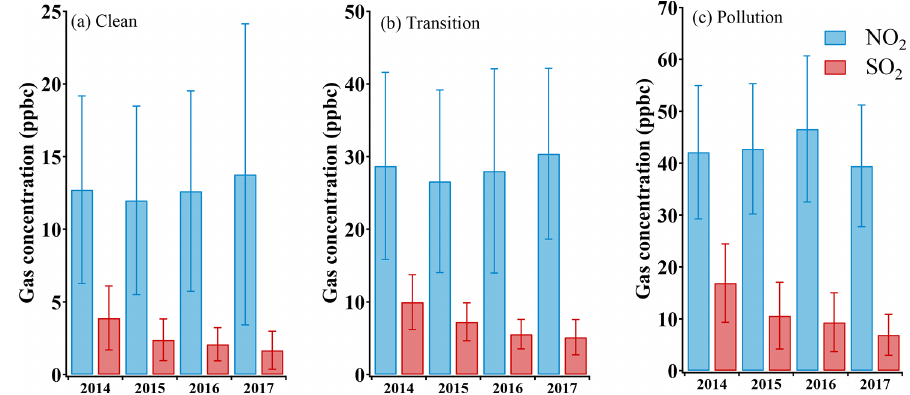
Figure 2. Statistics plot of NO 2 and SO 2 measured in downtown Beijing at different PM 2 . 5 levels during winter (December–February) for the past 4 years. Historical data (2014–2016) are from the air quality real-time publishing platform China National Environmental Monitoring Center, and data of 2017 have been obtained during the campaign. Table 1. Visibility and concentrations of major pollutants in Beijing during the winter of 2017. Average Clean Transition Pollution Visibility (km)